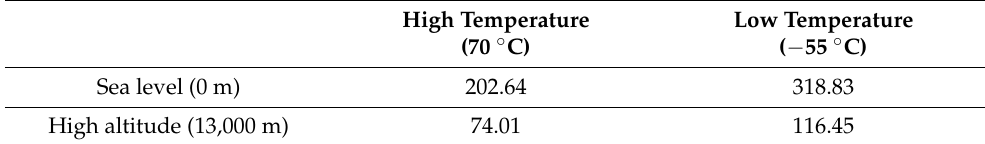
Table 7. Pressure generation under different operating conditions (unit: kg/m 2 ).